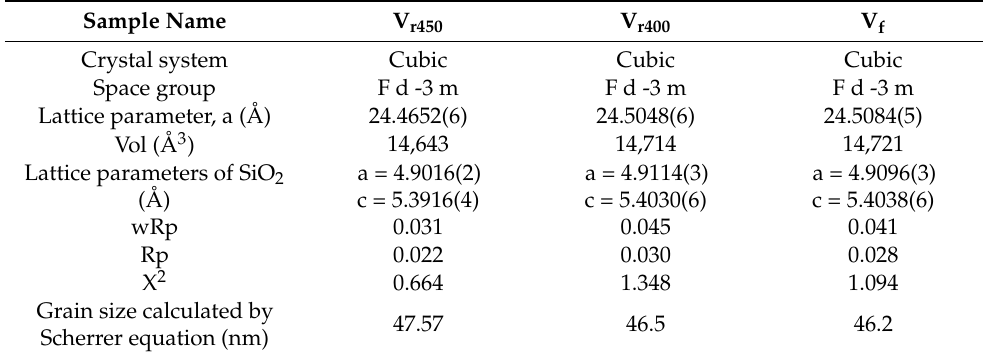
Table 3. Results of crystal parameters by Rietveld refinement.